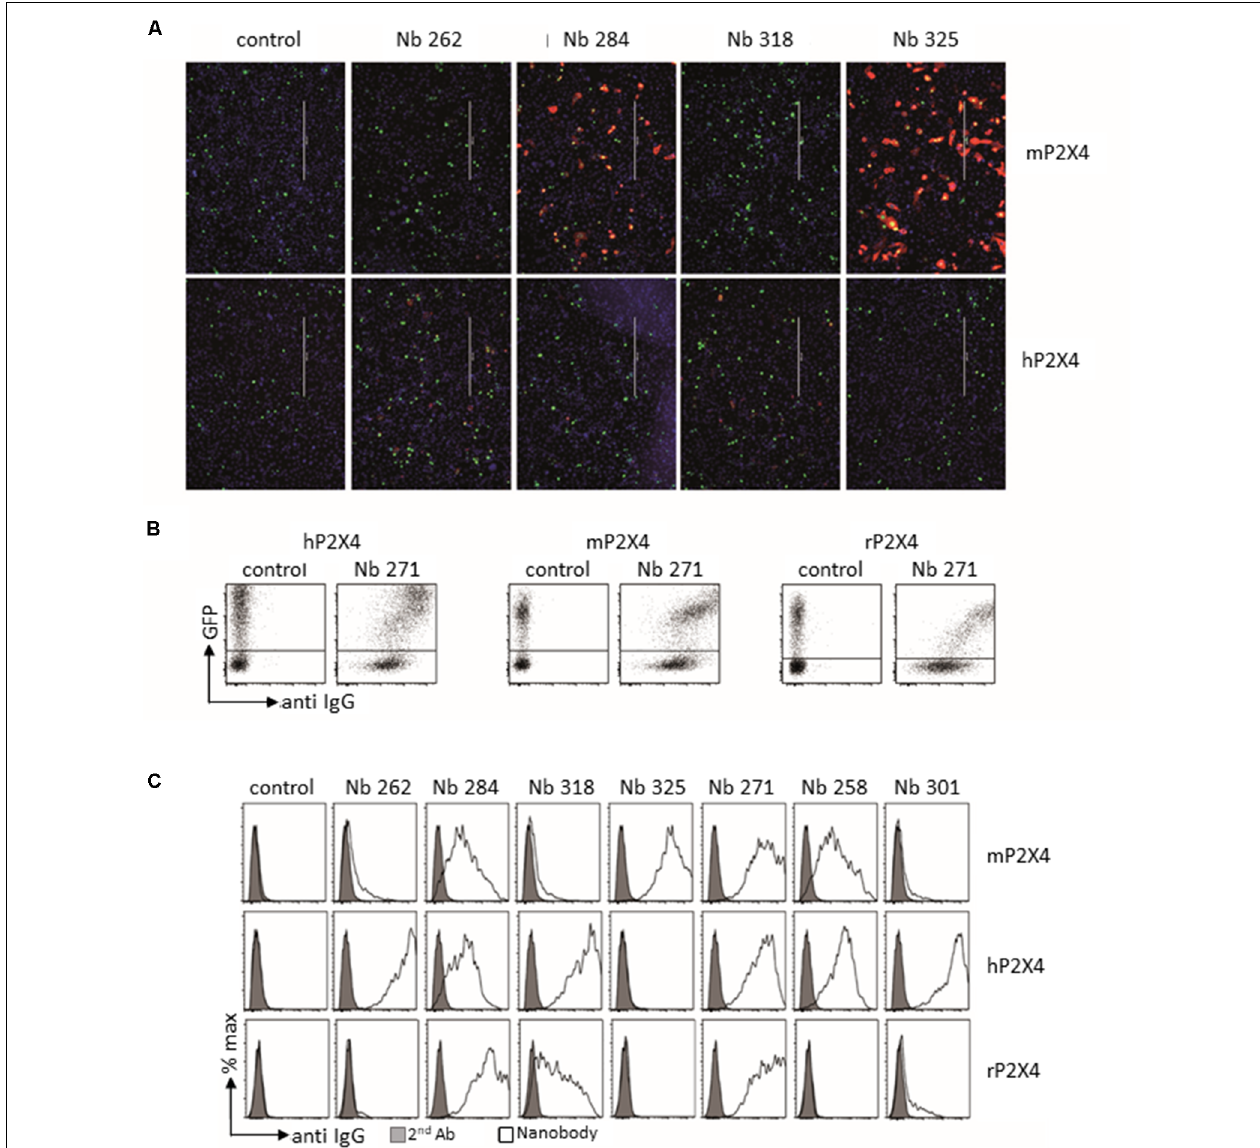
FIGURE 5 | Analysis of cloned nanobodies against mouse or human P2X4. (A) Immunofluorescence analysis of the reactivities of monovalent his6x-c-myc-tagged nanobodies with non-permeabilized CHO cells transiently co-transfected with GFP and either mouse (top panel) or human (bottom panel) P2X4 Y378F. Bound nanobodies were detected by sequential staining with a C-myc tag-specific mouse mAb followed by PE-conjugated rabbit anti-mouse IgG. Scale bar: 400 µ m. (B,C) Flow cytometry analysis of the binding specificity of the different selected nanobodies. HEK cells were co-transfected with GFP and either human, mouse, or rat P2X4 Y378F. The FACS analyses in (B,C) were performed on transiently transfected HEK cells using bivalent Nb-rabbit IgG heavy chain antibodies. Bound antibodies were detected with Alexa 647-conjugated goat anti-rabbit IgG. (B) Example of results obtained with Nb 271, which binds all tested P2X4 receptors. (C) Binding specificity of the different selected nanobodies. Gray graphs correspond to control staining using only the secondary antibody. Nb isotype corresponds to a control with an unrelated isotype nanobody. The different staining protocols used to account for the stronger labeling intensity of human P2X4 transfected cells in (B,C) vs. (A) . The relative staining intensities of the nanobodies are the same in panels (A,B) , i.e., for mP2X4: 325 > 284 > 318 = 262 and for hP2X4: 262 > 318 > 284 >